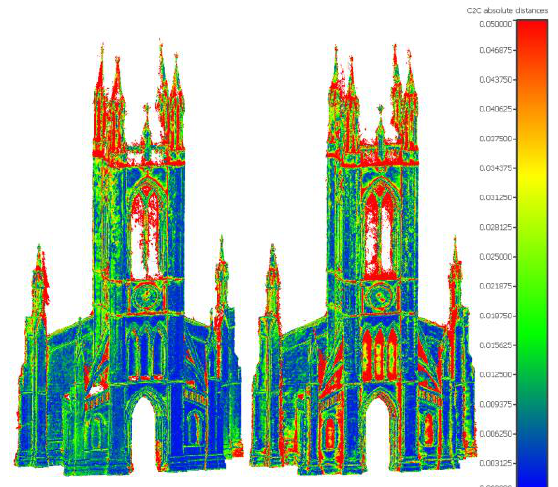
Figure 9. C2C distances of Photoscan point clouds with 30 photos (left) and 150 photos (right). Red is 5cm and above